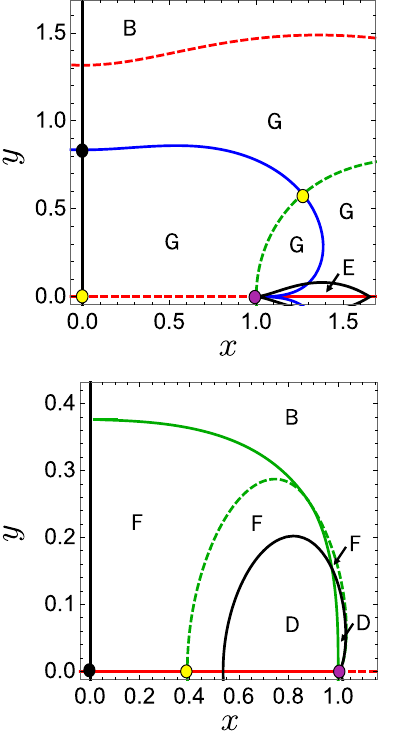
FIG. 20. Critical initial condition set F − 1 ð Σ Þ , shown in the ð x; y Þ plane with p x ¼ p y ¼ 0 , for insert strengths τ ¼ − 1 (upper) and τ ¼ þ 0 . 4 (lower). Only one quadrant is shown. Colors and labels correspond to those found in Figs. 16 – 17. Black dot — stable fixed point. Yellow dot — unstable fixed point. Purple dot — singular point (not considered part of the phase space M